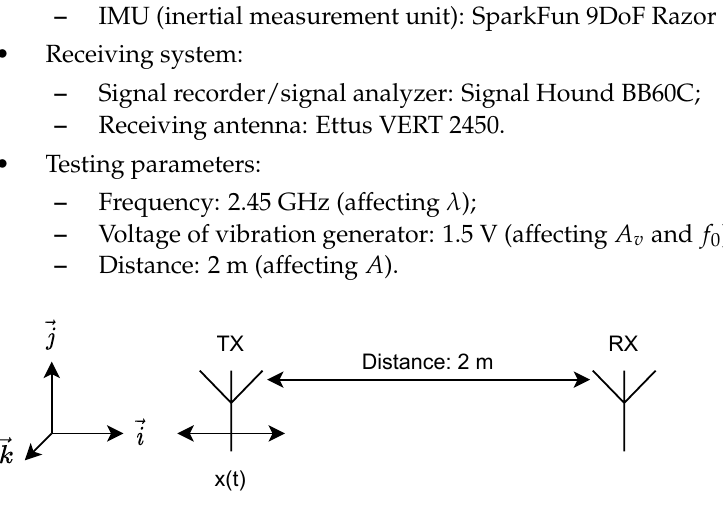
Figure 2. Experiment setup.